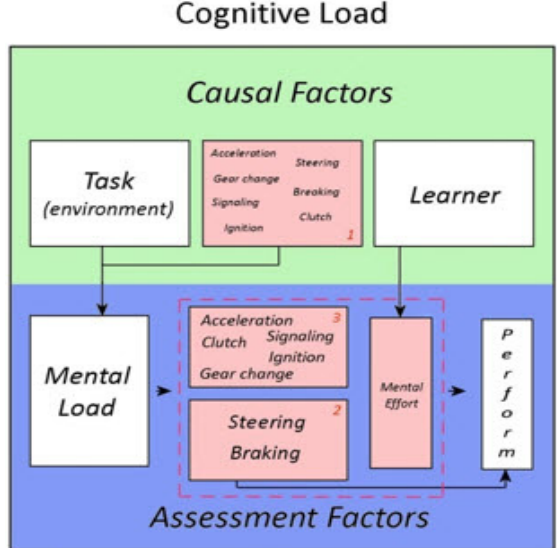
Figure 2. Interactions traced through the Cogni- tive Load